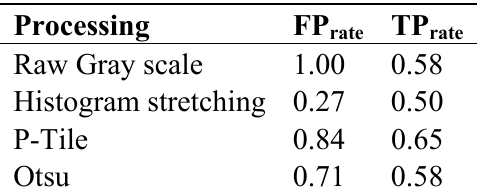
Table 2. True and false positives in the first interval (20–30)% of correlation for the best preprocessing treatment.